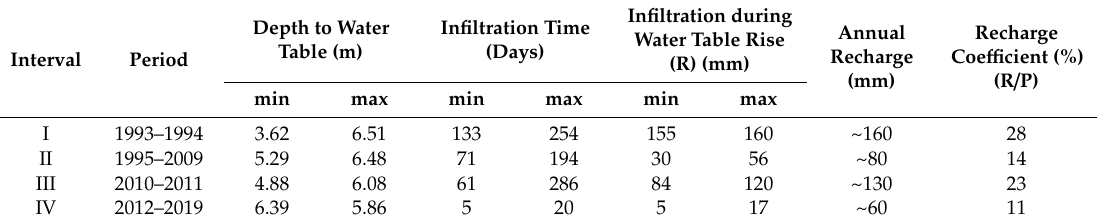
Table 4. Assessment of recharge of the shallow Quaternary aquifer using the WTF method.